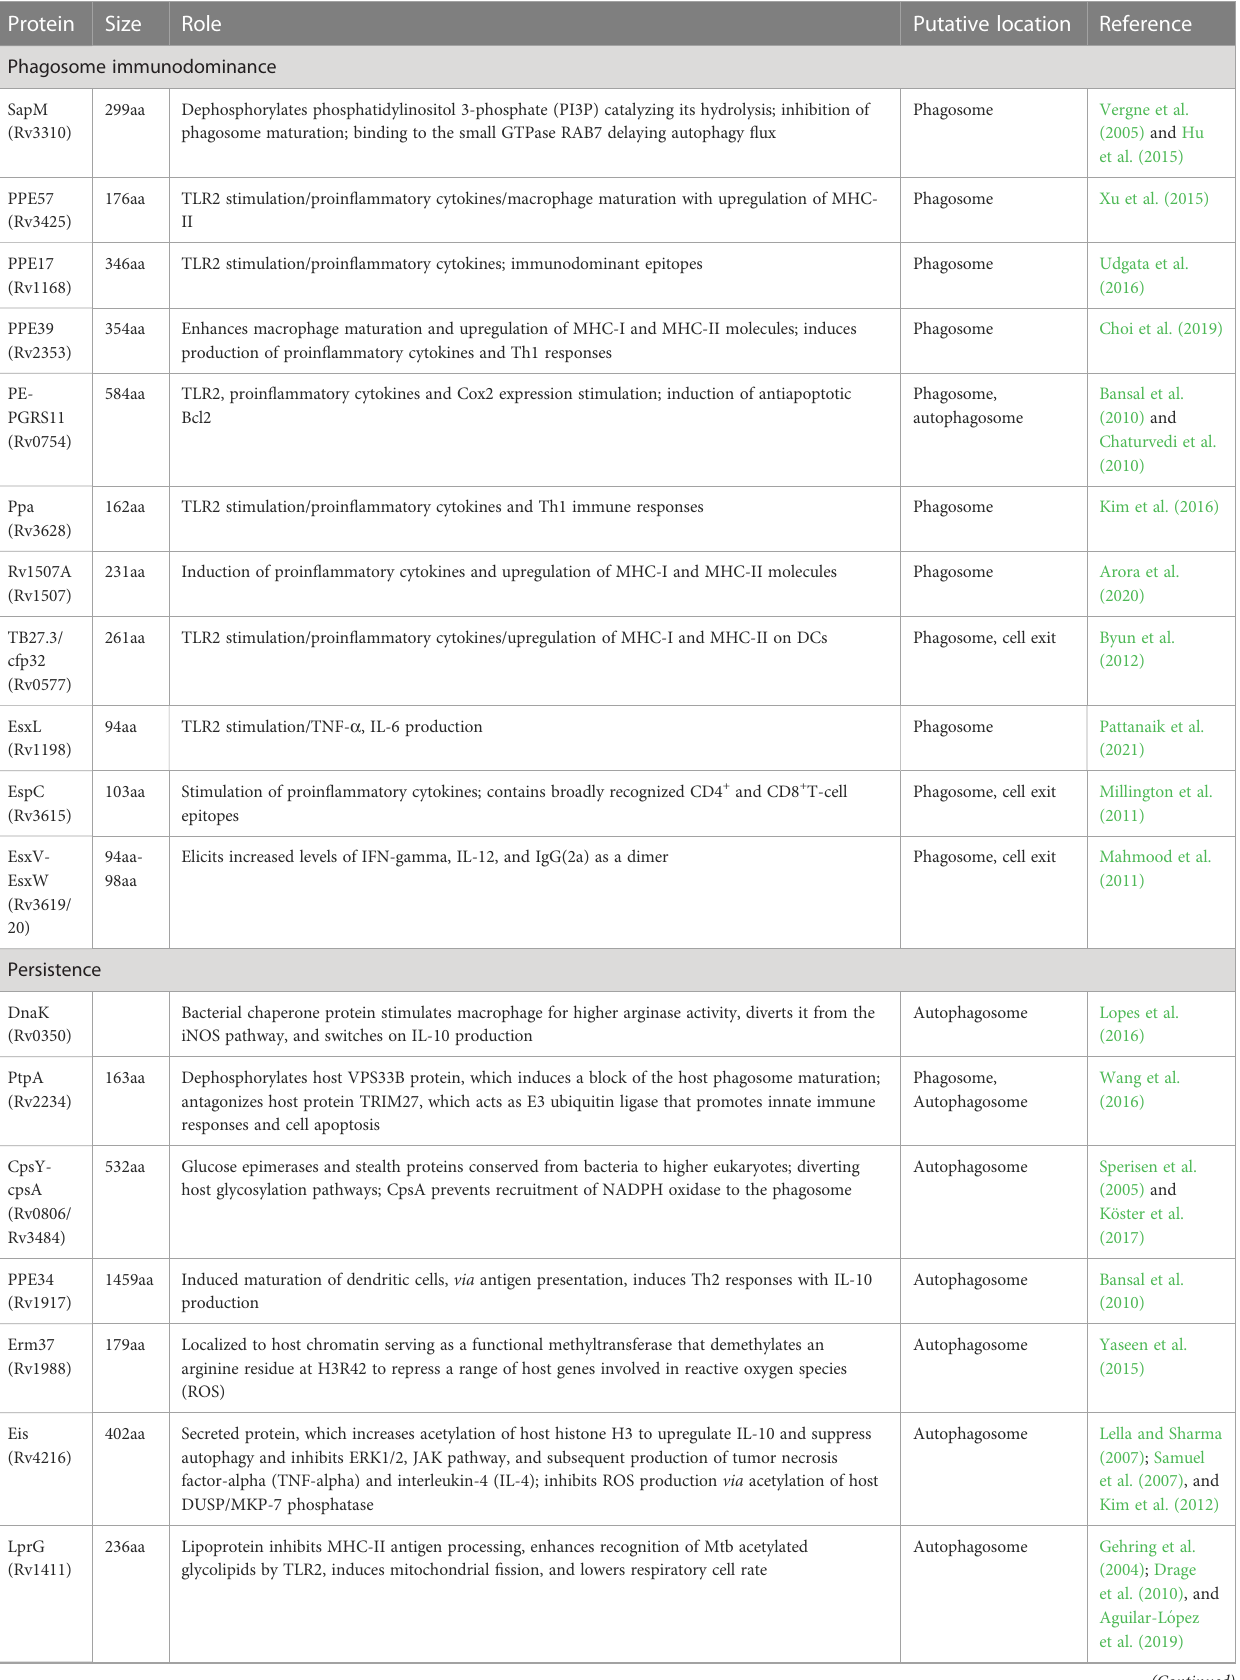
TABLE 1 Selected Mycobacterium tuberculosis virulence factors participating in host virulence